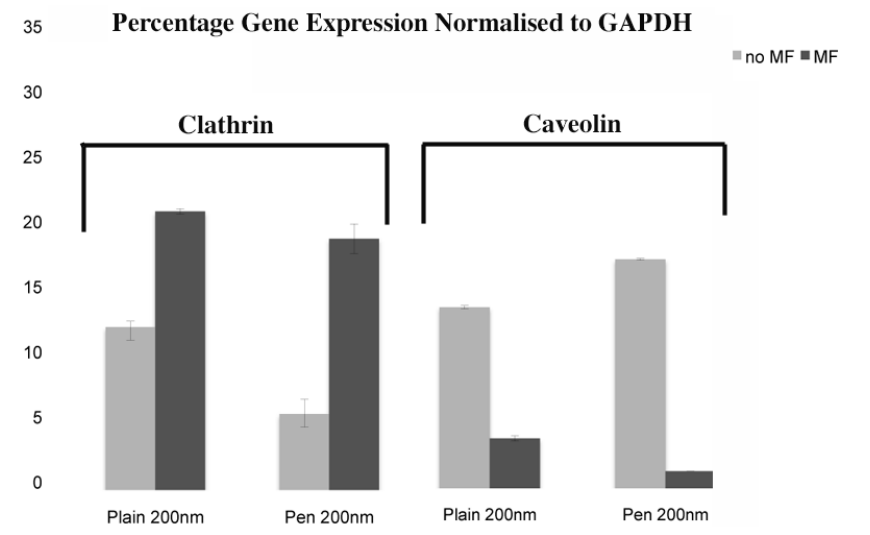
Figure 5. Clathrin and caveolin expression as assessed by qRT-PCR, normalised to GAPDH (n = 3, from two experiments, +/-